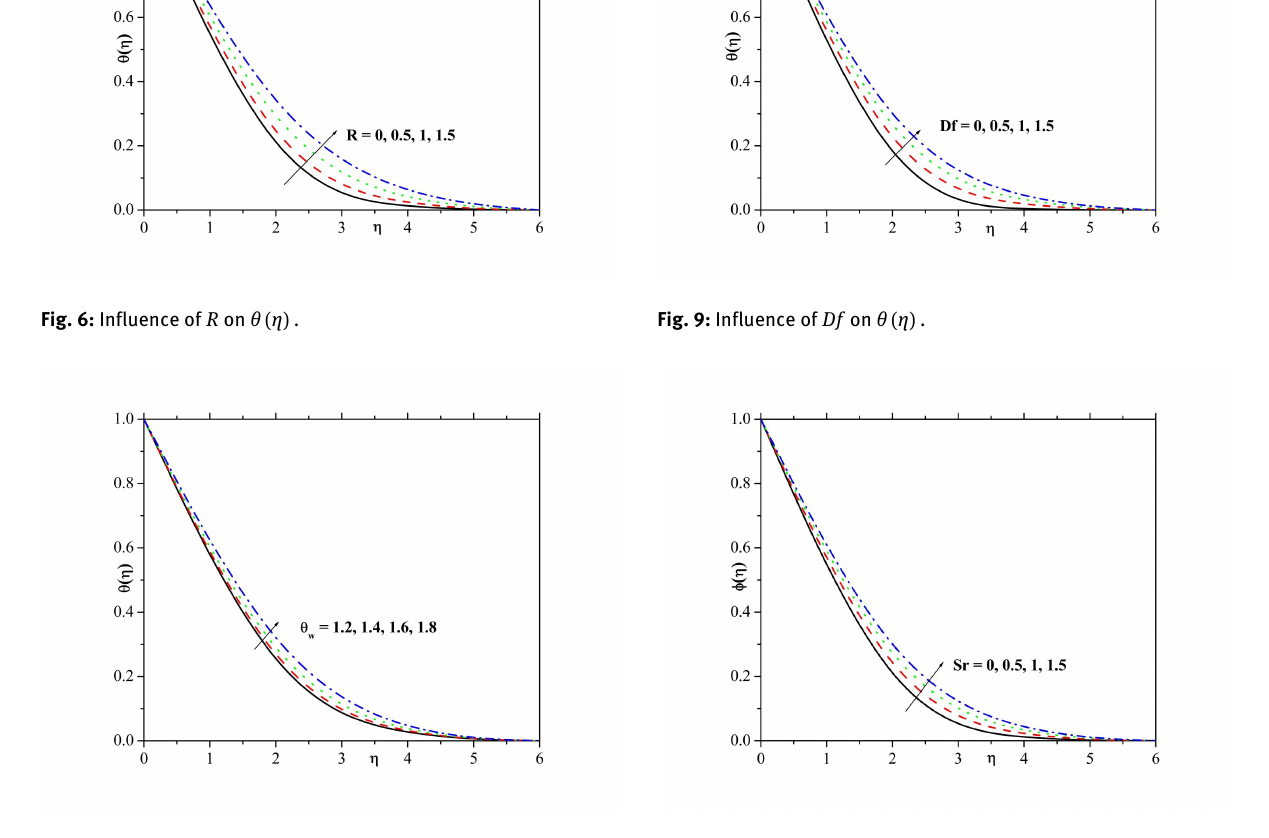
Fig. 7: Influence of θ w on θ ( η ) .